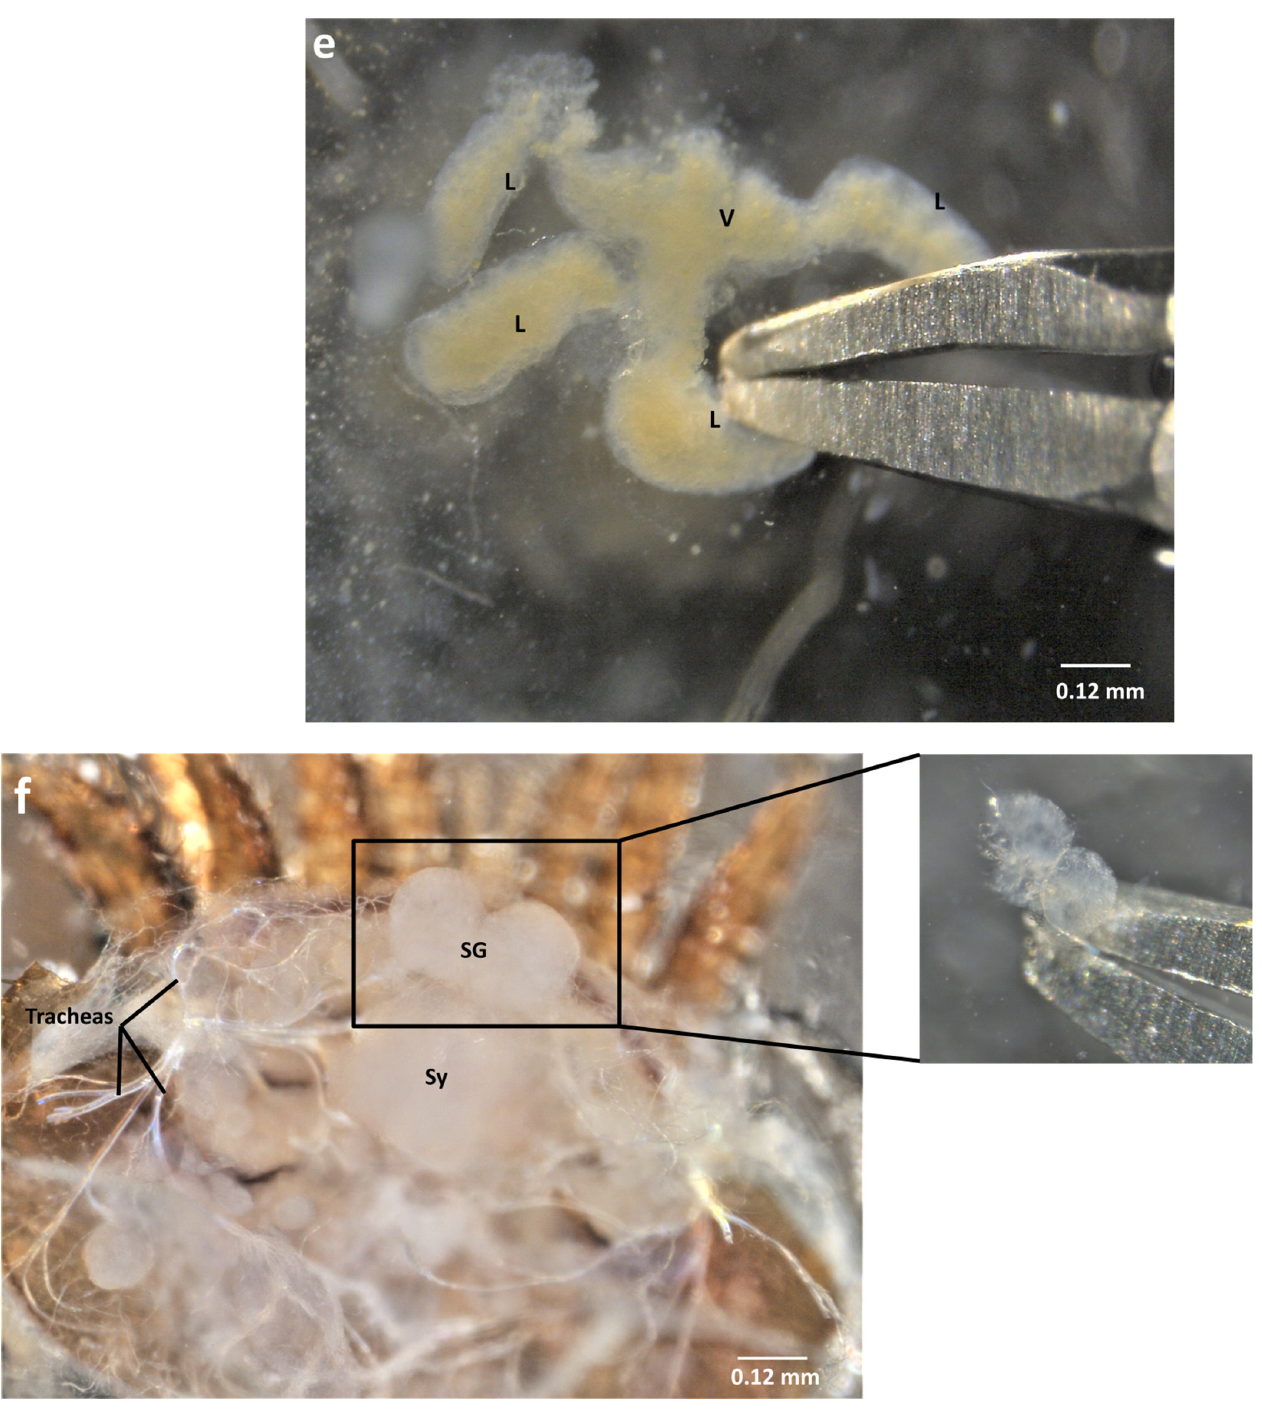
Figure 4. Pictures of the internal anatomy of dispersive or reproductive V. destructor females (sampled on adults or honey bee pupae, respectively) during dorsal dissection; ( a ) view after the dorsal shield is removed; ( b ) after the layer of tracheas and fat bodies are removed; ( c ) once the Malpighian tubules are extracted; ( d ) Malpighian tubule removed; ( e ) extracted digestive tract of the mite (without the rectum); ( f ) salivary glands observed within the mite’s body and once extracted. (L = caecal lobes; MT = Malpighian tubules; Ov = ovary; Re = rectum; SG = salivary glands; Sy = synganglion; V = ventriculus).